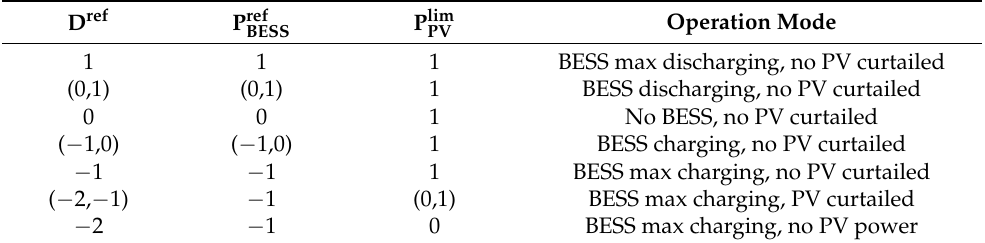
Table 2. Integral controller action and the corresponding power setpoints and limits.